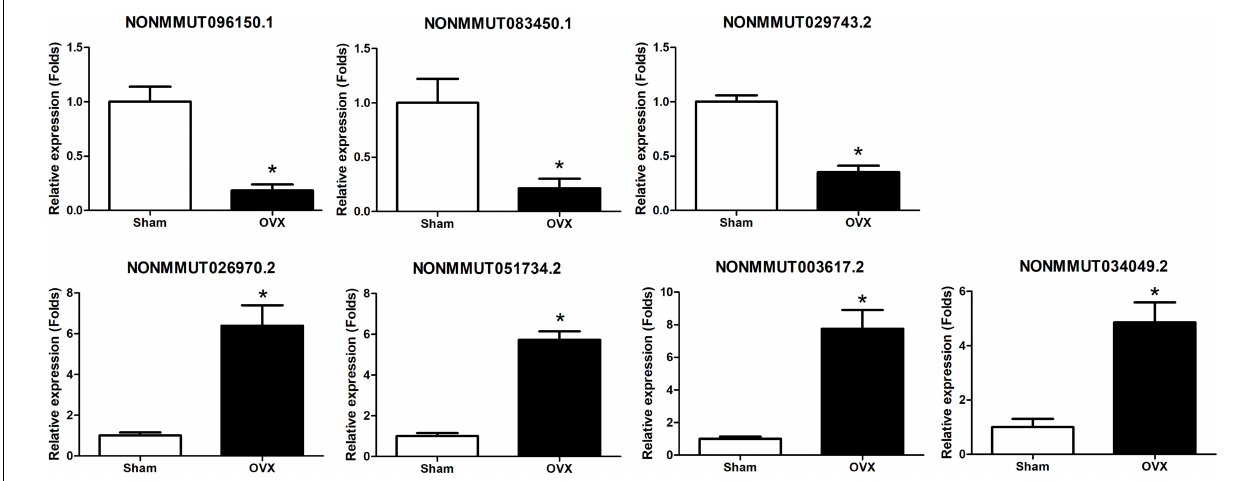
FIGURE 8 | Validation of DElncRNA expression by qRT-PCR between OVX mice and controls. * p < 0.05 vs Sham